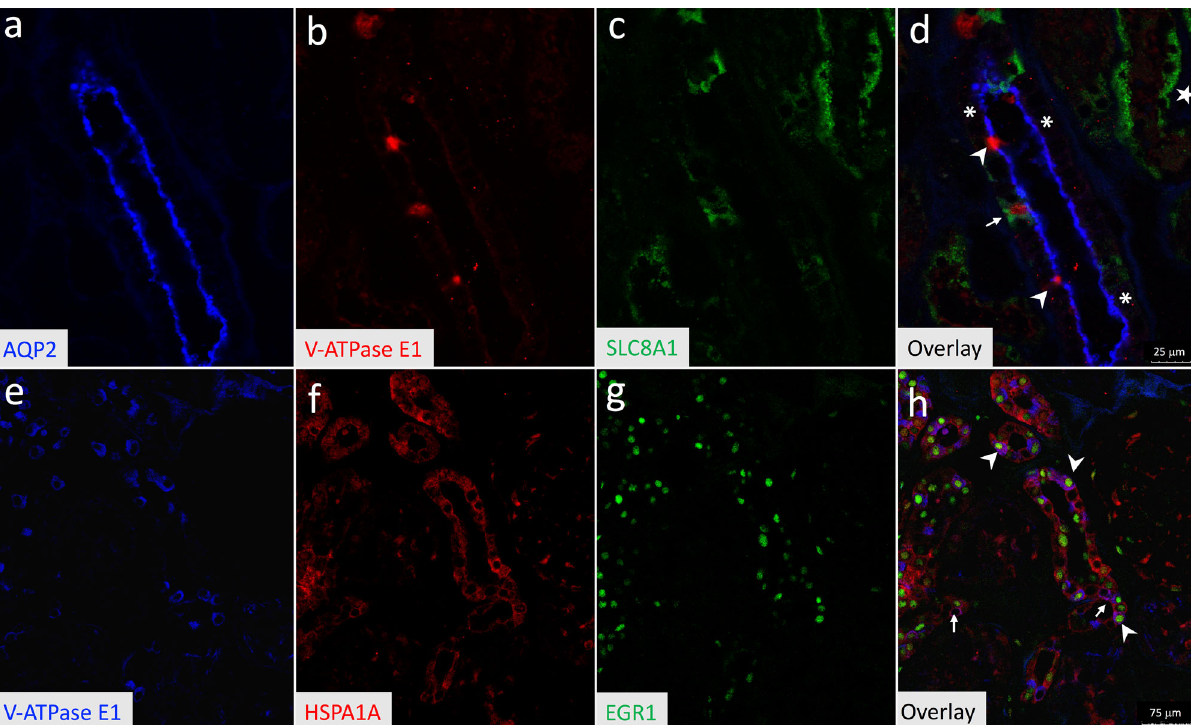
Fig. 3 Hybrid PCs – ICs and IC subtypes are seen on fl uorescent immunolabeling. Triple- fl uorescent immunolabeling was completed with the PC marker AQP2 (blue) ( a ), the IC marker V-ATPase E1 (red) ( b ), and proposed hybrid PC – IC cell marker SLC8A1 (green) ( c ), and images were obtained using confocal microscopy. The overlay ( d ) demonstrates a triple-labeled hybrid PC – IC cell (arrow), along with cells with only AQP2 labeling consistent with PCs (asterisks) and cells only with V-ATPase E1 labeling (arrowheads) consistent with ICs. Some tubules that did not express V-ATPase E1 or AQP2 had a majority of cells that were positive for SLC8A1 (star). Triple- fl uorescent immunolabeling was also completed for A-IC subtypes with V-ATPase E1 (blue) ( e ), HSPA1A (red) ( f ), and EGR1 (green) ( g ). The confocal microscopy image overlay ( h ) contained cells with V-ATPase E1, HSPA1A, and EGR1 labeling consistent with A-IC subtype B (arrowheads) along with cells with HSPA1 and V-ATPase E1 but not EGR1 labeling consistent with A-IC subtype A (arrows). Representative images are presented from human kidney sections from two distinct individuals. Source data are provided as a Source Data